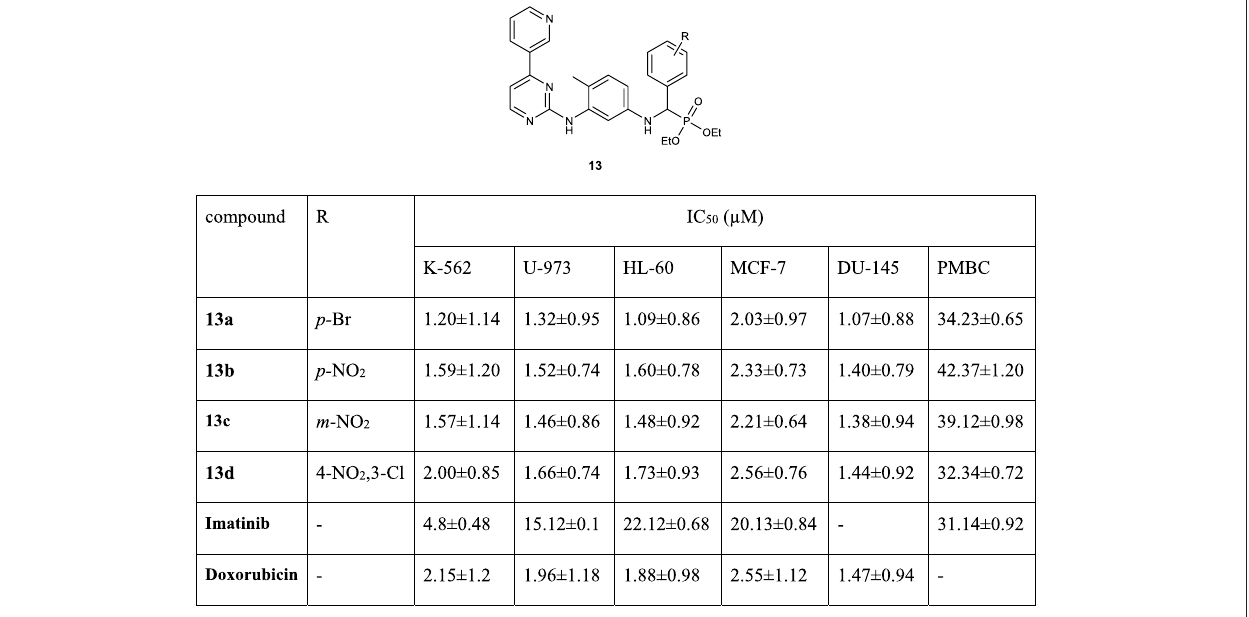
FIGURE 2 | Structures of the compound 13 and its biological